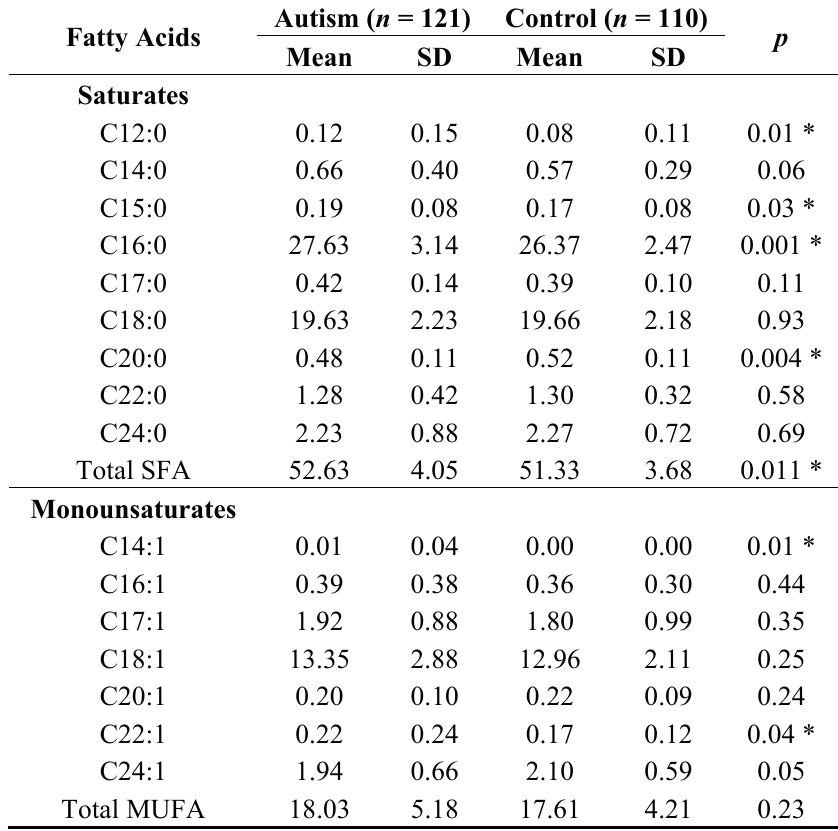
Table 1. Differences in fatty acid composition between autistic patients and unaffected individuals. Fatty